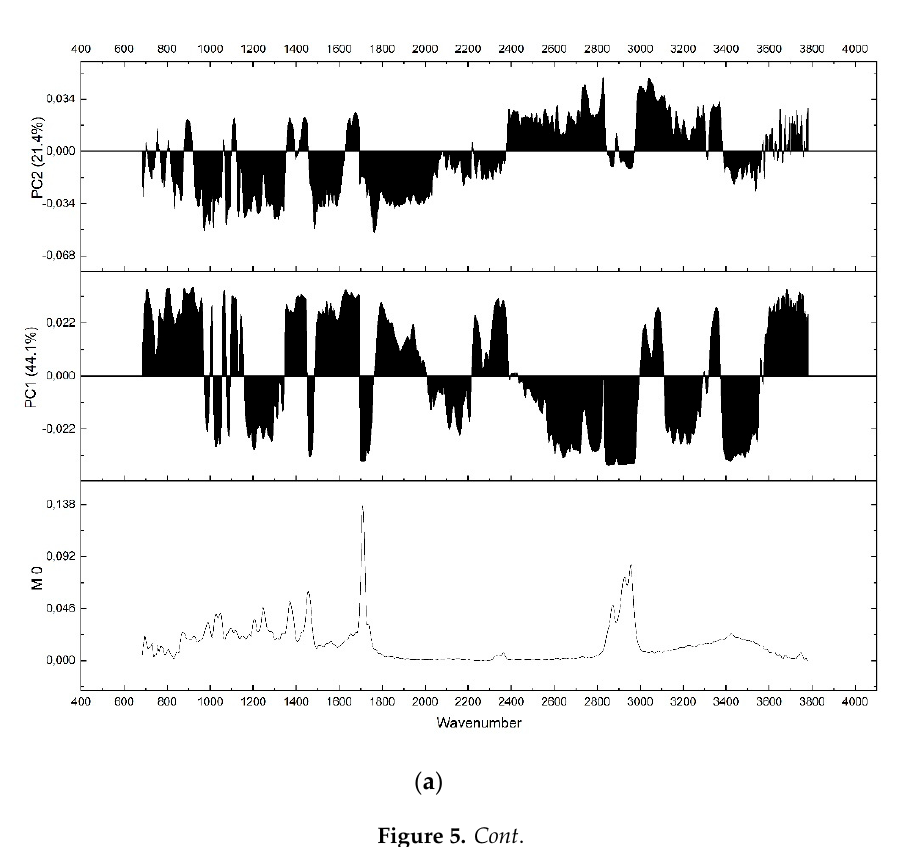
Figure 4. The score plot of PC1 and PC2 for all samples.